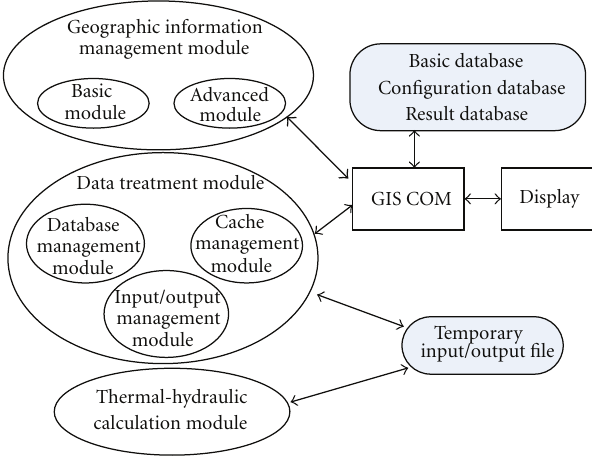
Figure 5: Structure and function of the